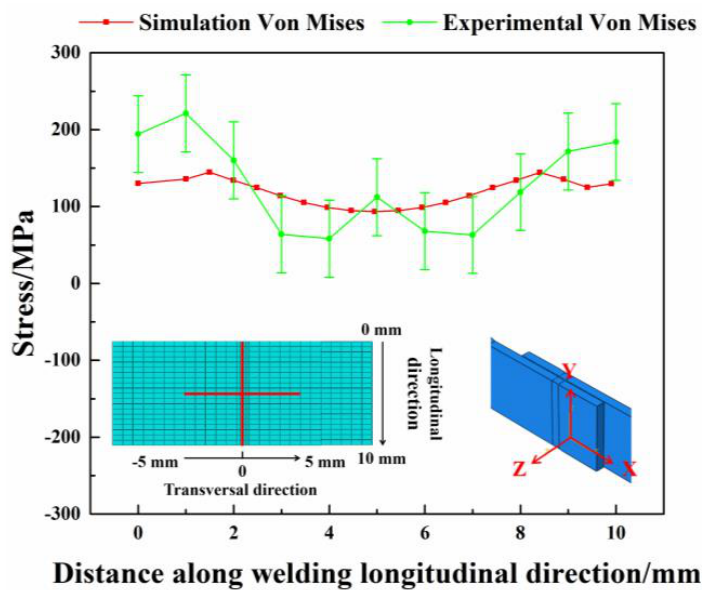
Figure 19. Low-cycle fatigue residual stress by simulation and experiment.